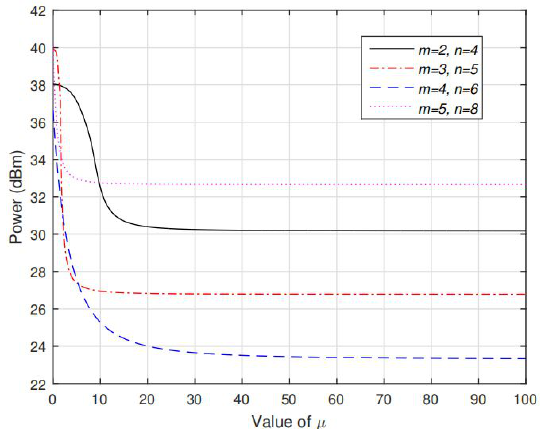
Figure 6. Value of ˜ g ( s ( µ ) /˜ s ) as function of µ under different settings of m , n . ˜ s is set as [ 1,1,...,1 n ] T , given each fixed value of µ , s ( µ ) is set as Equation (21) under the inactive Equation (12). Note that ˜ g ( s ( µ ) /˜ s ) is monotonically decreasing in µ .